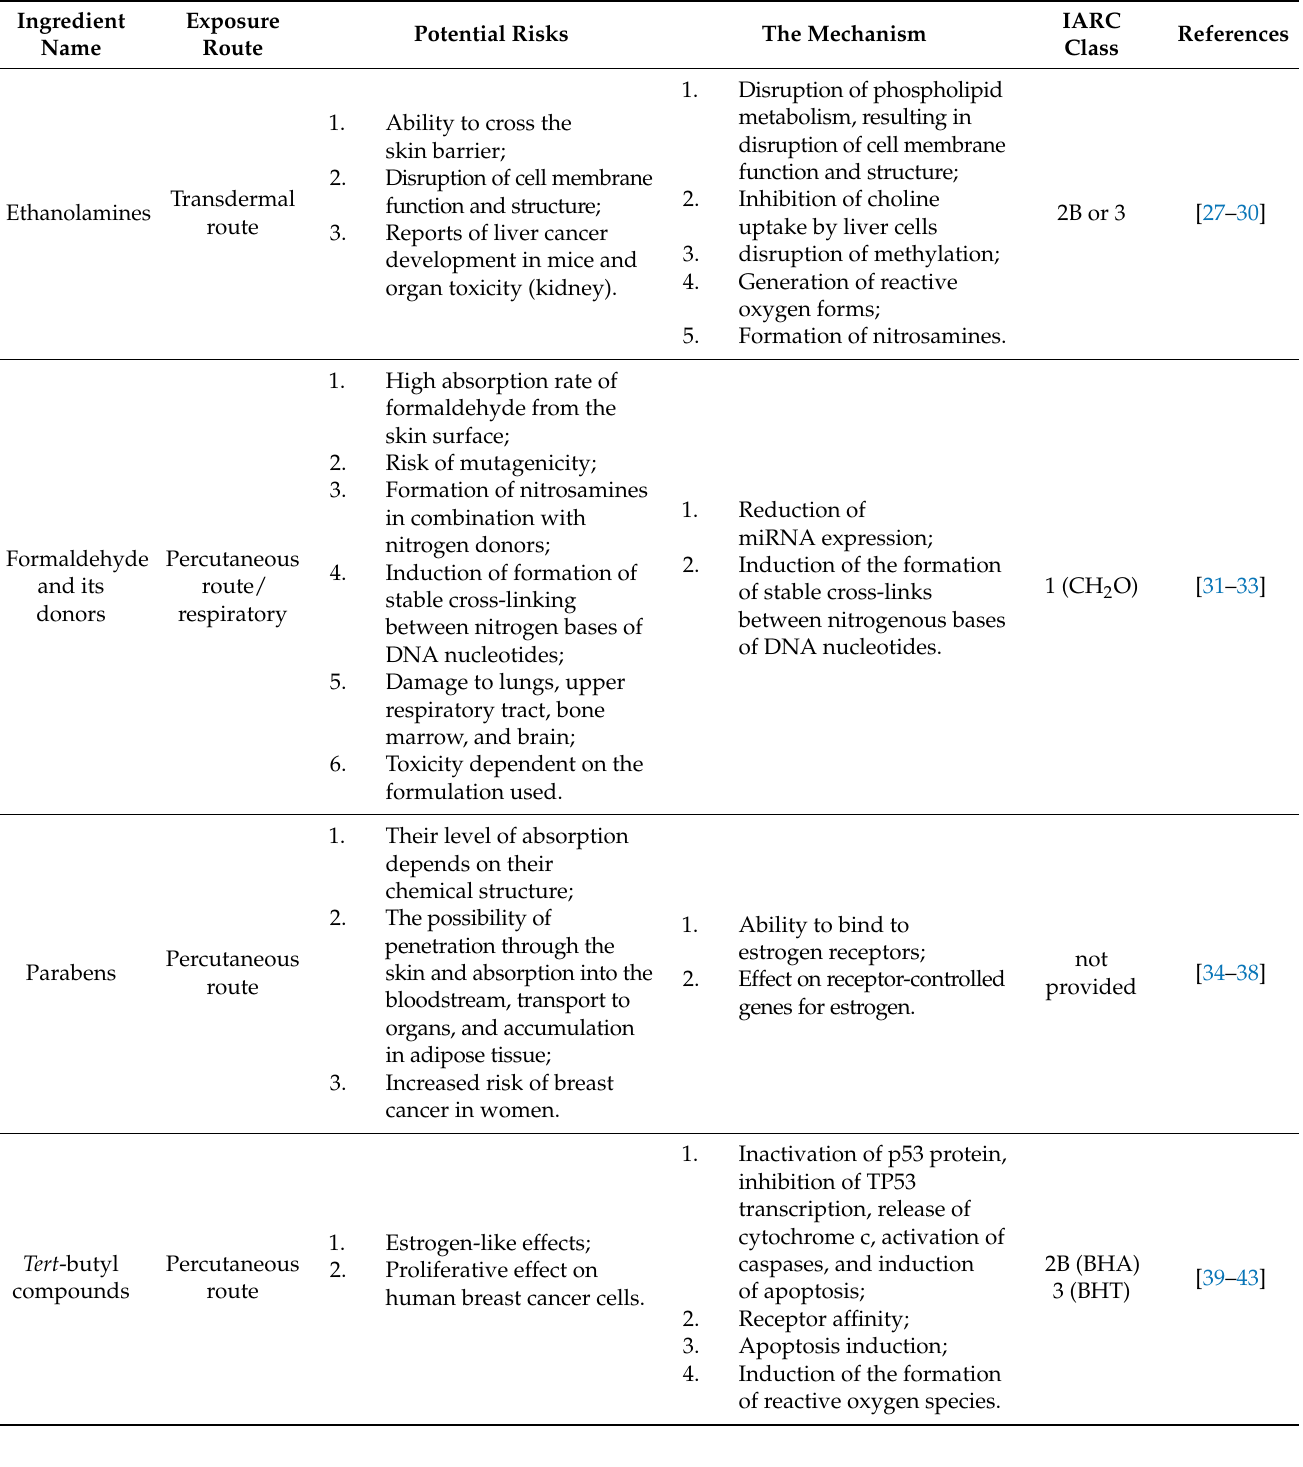
Table 2. Potentially carcinogenic substances in cosmetics, together with the potential risks and mechanisms of